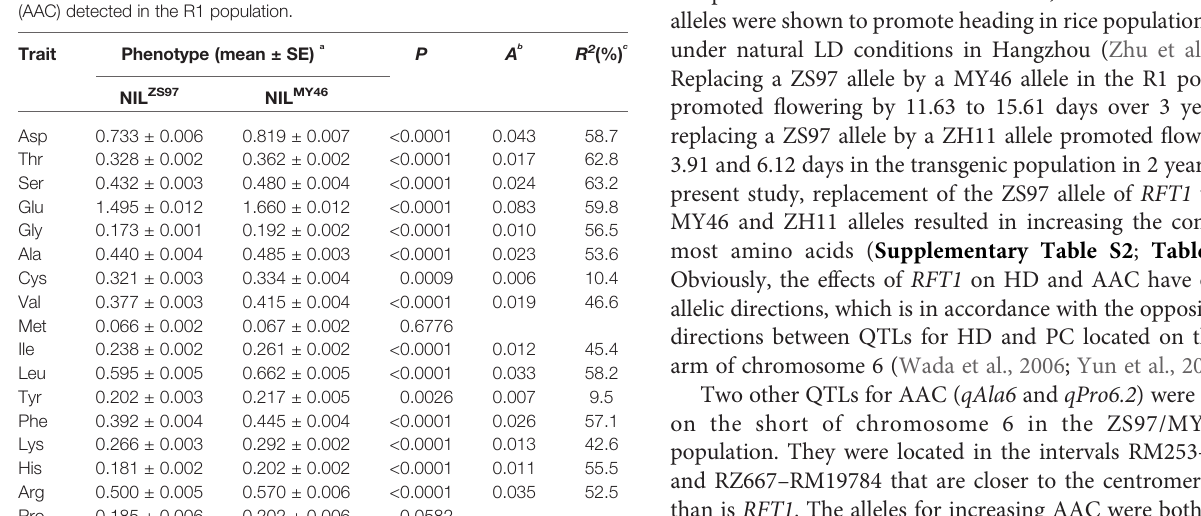
( Table 2 ; Supplementary Table S1 ), most of the QTLs were located in cluster and different QTL in a given region usually had the same allelic direction ( Figure 1 ; Supplementary Table S2 ). RFT1 protein is the fl origen for promoting the fl owering of rice under long-day (LD) conditions (Tsuji et al., 2011). As